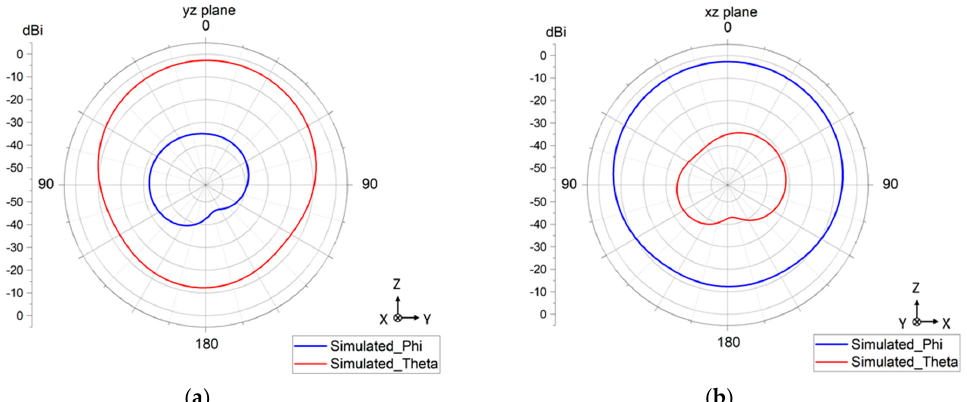
Figure 23. The 3D field simulation diagram at 38 GHz.